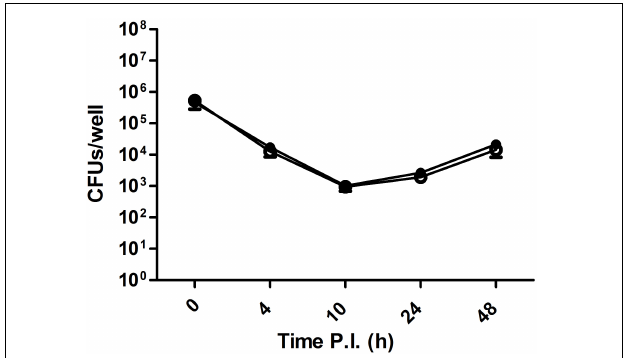
FIGURE 6 | Competitive index assay of a mixture of Brucella abortus 292 and its corresponding CO 2 -independent spontaneous mutant B. abortus 292mut1. The competitive index was calculated by dividing the output ratio of mutant to wild-type bacteria by the input ratio of mutant to wild-type bacteria, in the two groups tested, regarding the original inoculum. Thus, for strains with the same fitness, the result should be 1. The differences between groups were analyzed by Student’s two-tailed t test with significance set at ∗ P < 0.05. ns,